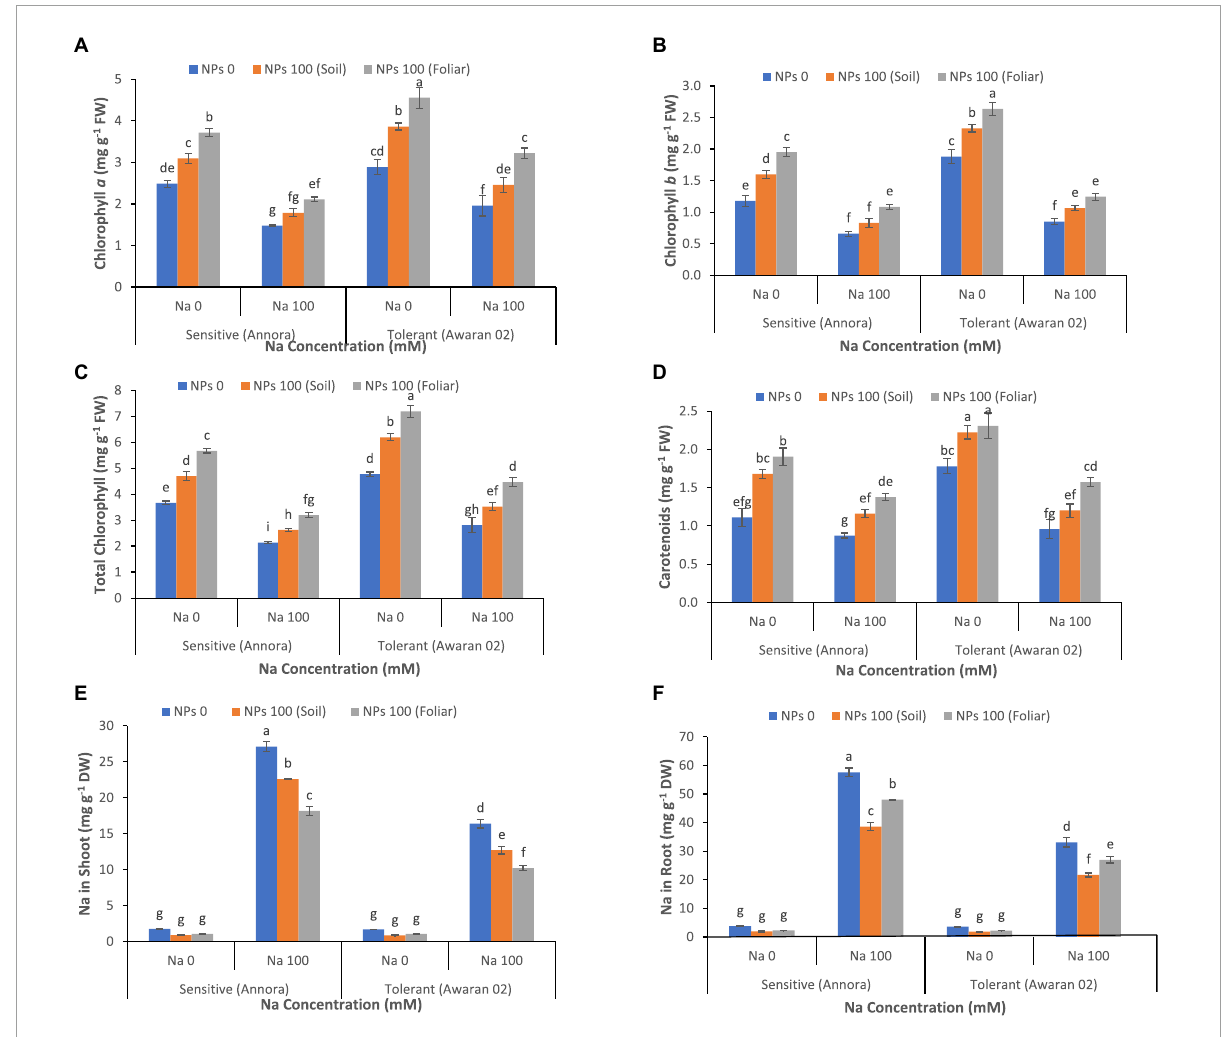
FIGURE2 Effects of different concentrations of NaCl (0 and 100 mM) and ZnO NPs (0, 100 mg kg − 1 soil, and 100 mg L − 1 foliar) on (A) chlorophyll a, (B) chlorophyll b, (C) total chlorophyll, (D) carotenoid contents, (E) Na + uptake in shoots, and (F) Na + uptake in roots of two barley genotypes Annora (salt sensitive) and Awaran 02 (salt tolerant). Values are expressed as means of three replicates with standard deviations. Different letters indicate that the values are significantly different at a p -value <